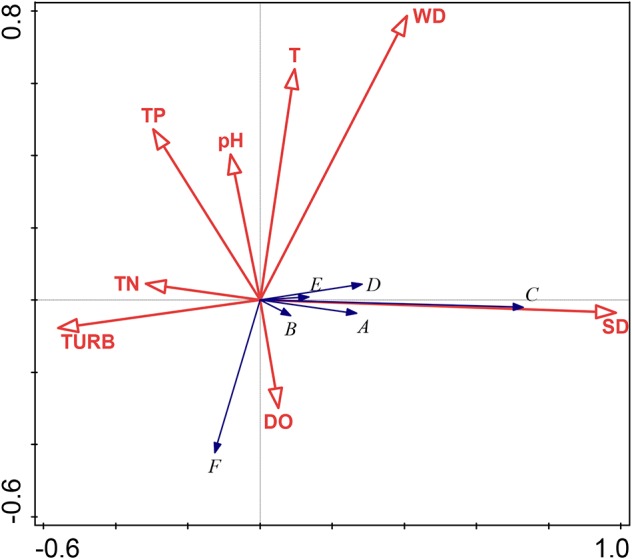
Redundancy analysis ordination diagram of the submerged plant and environmental factors. Species codes: A, Myriophyllum spicatum; B, Vallisneria spiralis; C, Potamogeton maackianus A. Bennett; D, Ceratophyllum demersum; E, Hydrilla verticillata; F, Potamogeton crispus. Environmental codes: DO, Dissolved oxygen; pH, pH of water; SD; Transparency; T, Temperature; TN, Total nitrogen; TP, Total phosphorus; TURB, Turbidity; WD, Water depth.